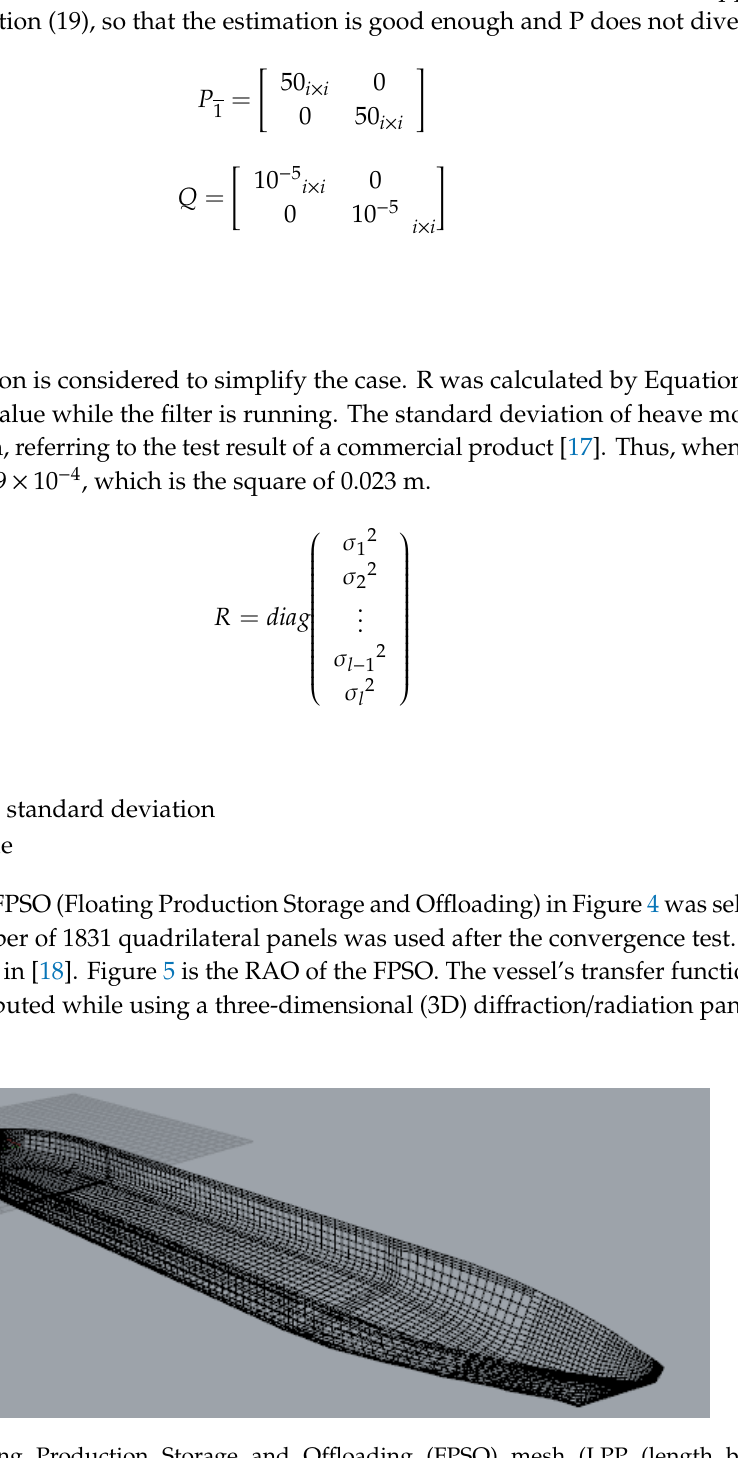
( a ) RAO ( b ) Phase Figure 5. Heave transfer function of FPSO. A uni-directional JONSWAP wave spectrum with Hs = 2 m, Tp = 7 s, and enhancement parameter = 2.2 is considered. The significant wave height, Hs is defined as the average of the 1/3 largest waves. It can be calculated from either wave spectrum or wave time series. Tp is the spectral peak period. Hs and Tp are used as key index parameters since the purpose of the Kalman filtering is to inversely estimate the overall shape of the spectrum. Subsequently, the corresponding heave motion spectrum was calculated while using the calculated RAO. Afterwards, the corresponding irregular-motion time series were generated by Equation (29). Subsequently, a white noise that was equivalent to the standard deviation of sensor error 2.3 cm was artificially added (Figure 6). Afterwards, the motion-time-series data, including the sensor error, was inputted to the present Kalman filter process. The frequency range of the white noise is set to be the same as that of input wave spectrum.